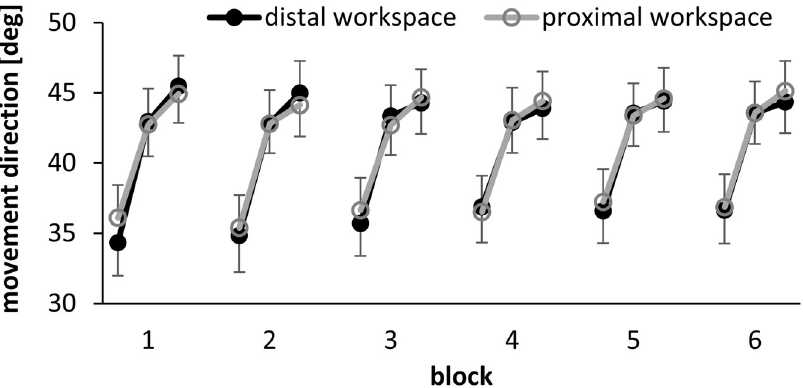
Fig 6. Progress of adaptation across episodes and blocks in the distal and proximal workspace. 65˚ represents the expected value for complete adaptation. 0˚ represents the unadapted expectation. Each dot represents the mean and the bars the standard error of all participants of the intervention group in one